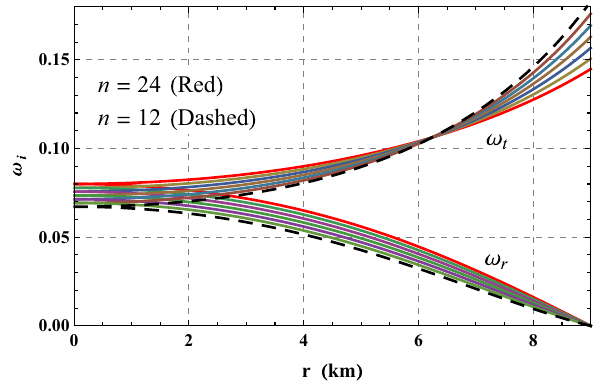
Fig. 15 Variationofequationofstateparameterswithradialcoordinate for the parameters given in Table